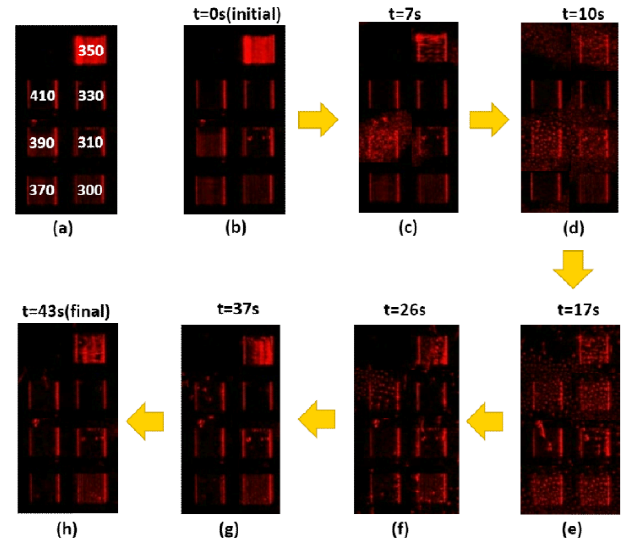
Figure 4. Images obtained from control samples with Ni gratings instead of Al grating (but with the same periodicity), showing no signs of transmission from ( a – h ). The pumping light is 532 nm. Liquid crystals are transformed from isotropic phase to nematic phase.